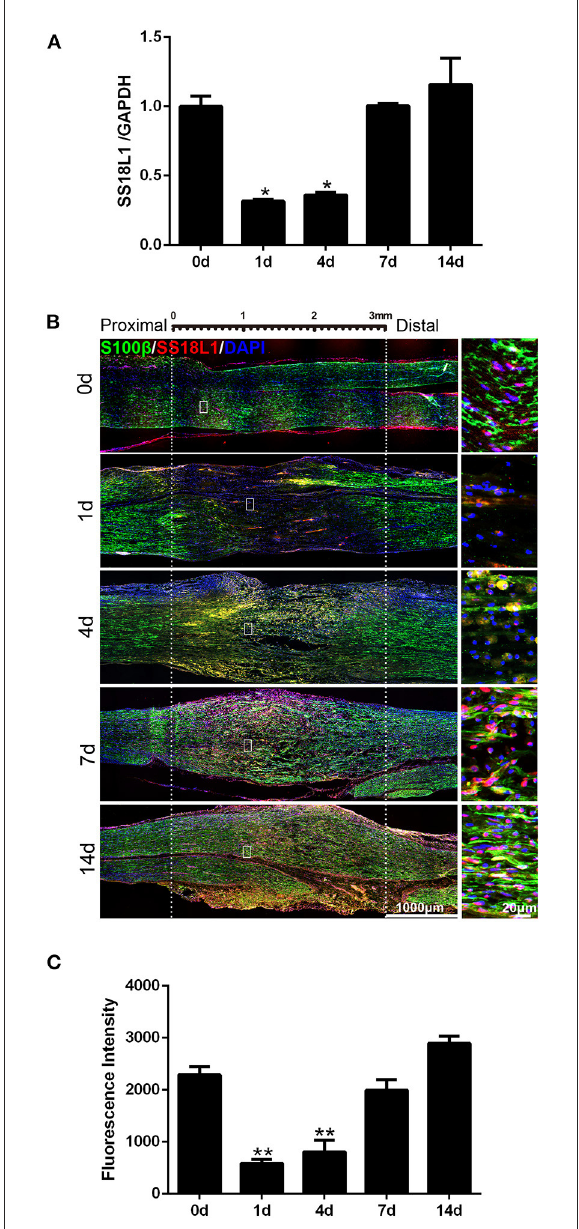
FIGURE1 Expression of SS18L1 in rat sciatic nerve stumps after peripheral nerve injury. (A) The relative mRNA expression of SS18L1 at 0, 1, 4, 7, and 14 days after sciatic nerve crush injury. * P < 0.05, vs. 0 day. (B) Immunostaining of SS18L1 (in red) and S100 β (in green) at 0, 1, 4, 7, and 14 days after sciatic nerve crush injury. DAPI (in blue) was used to stain nuclei. Scale bars indicated 1,000 µ m (main image), 20 µ m (magnification). (C) Quantification of the fluorescence intensity of SS18L1 staining in rat sciatic nerves at 0, 1, 4, 7, and 14 days after nerve injury. ** P < 0.01, vs. 0 day.